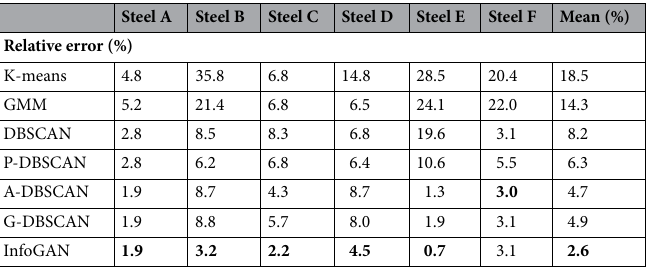
Table 6. Comparison of the proposed approach with baseline clustering models. Best results presented in bold font.